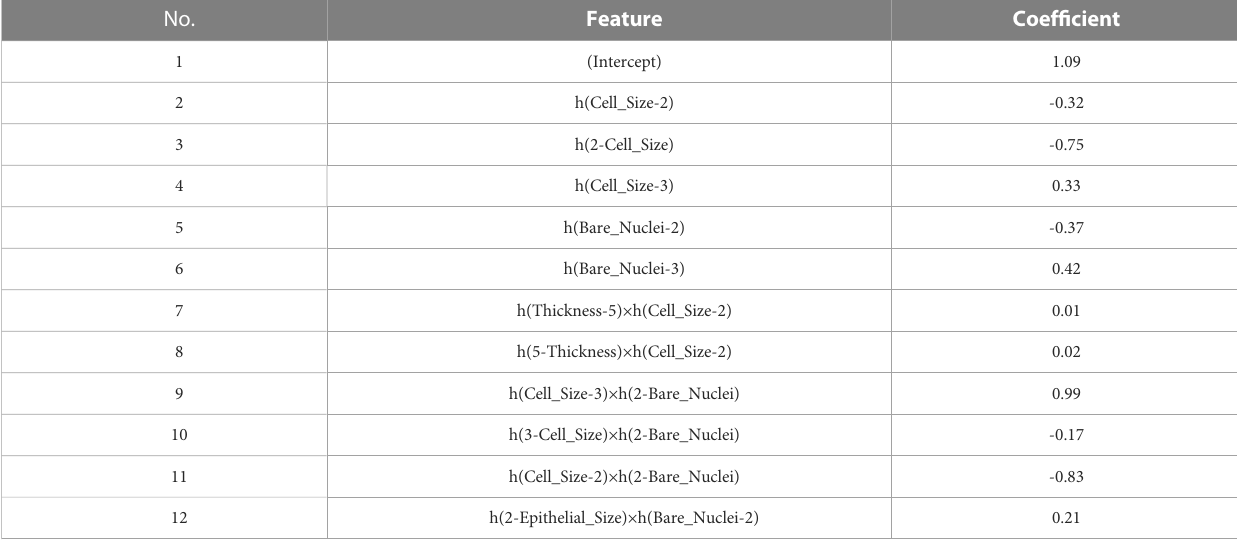
TABLE 2 Features and coef fi cients determined by the model using the multivariate adaptive regression splines (MARS) algorithm. No.